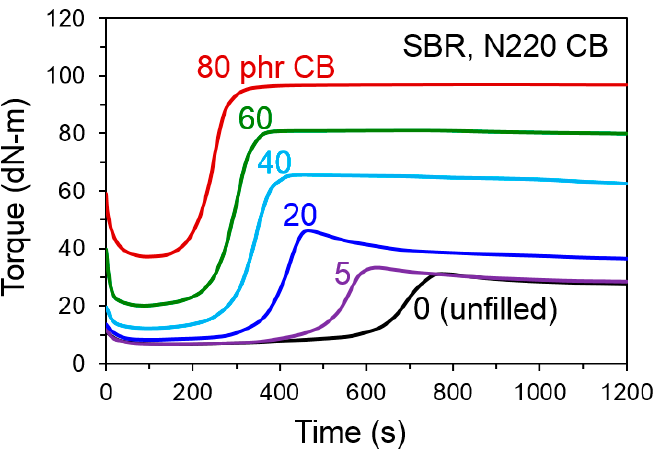
Figure 5. Rheological cure curves at 160 °C for sulfur vulcanization of SBR filled with N220 CB at the indicated loadings. Data replotted from Hossein and Razzaghi-Kashani [9].